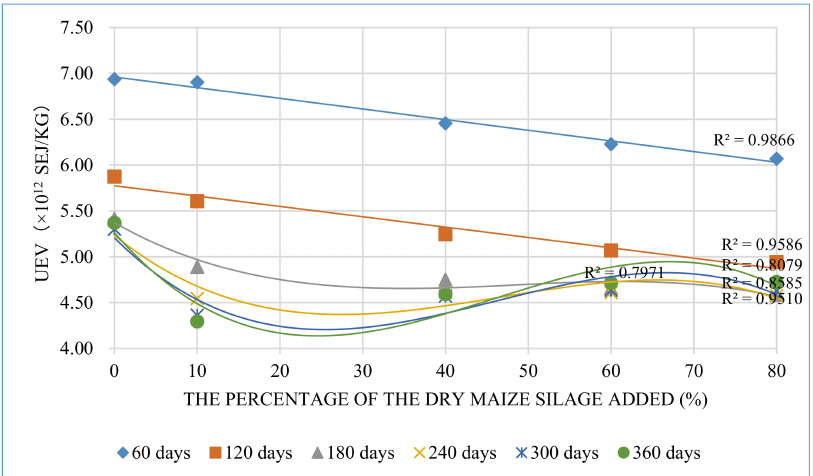
Figure 6. The trend of UEV changes with different percentages of maize silage.